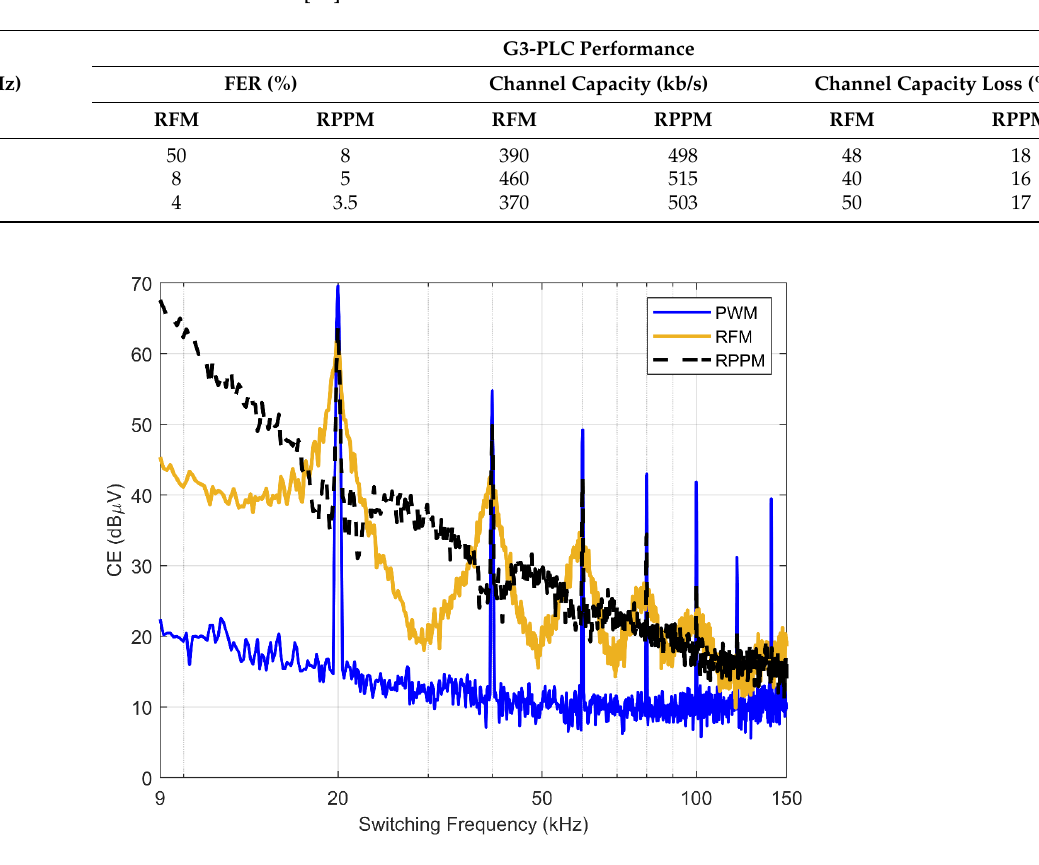
Table 3. Comparison of the performance of G3-PLC assessed with RFM and RPPM applied to the DC-DC converter [14].